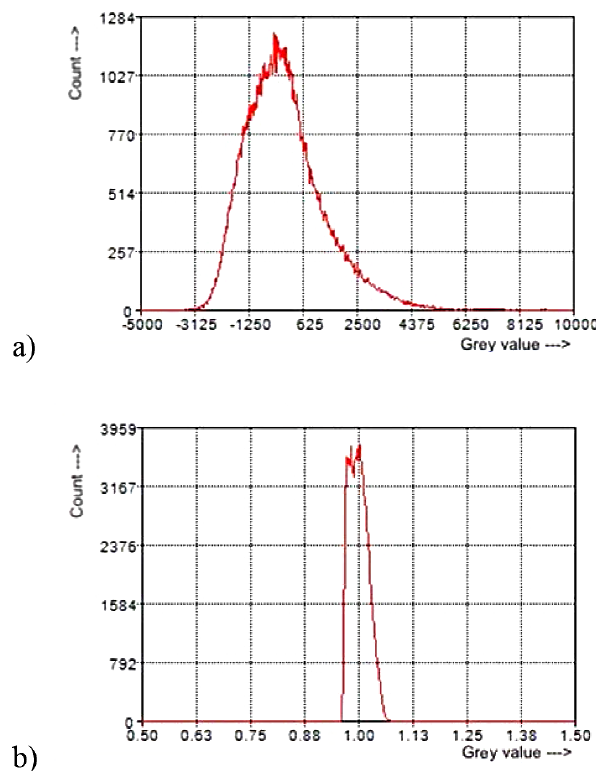
Figure 11. Histograms of (a) the offset values and (b) the gain val- ues of the microbolometer arrays under consideration.